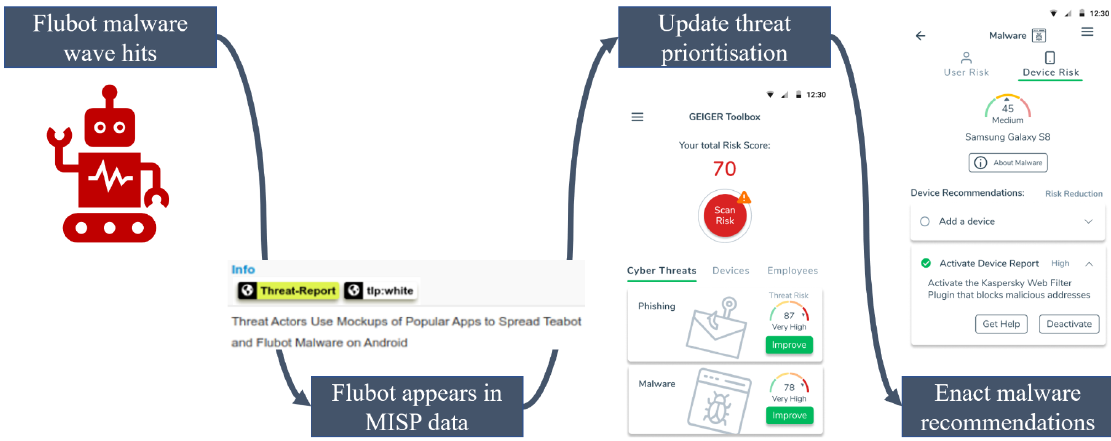
Figure 6. Our solution responds to the Flubot malware wave based on incoming MISP